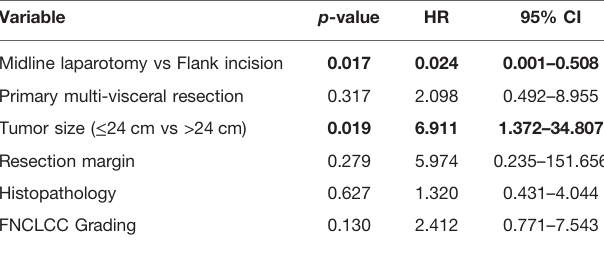
Table 3 | Cox Regression analysis for recurrence/local disease